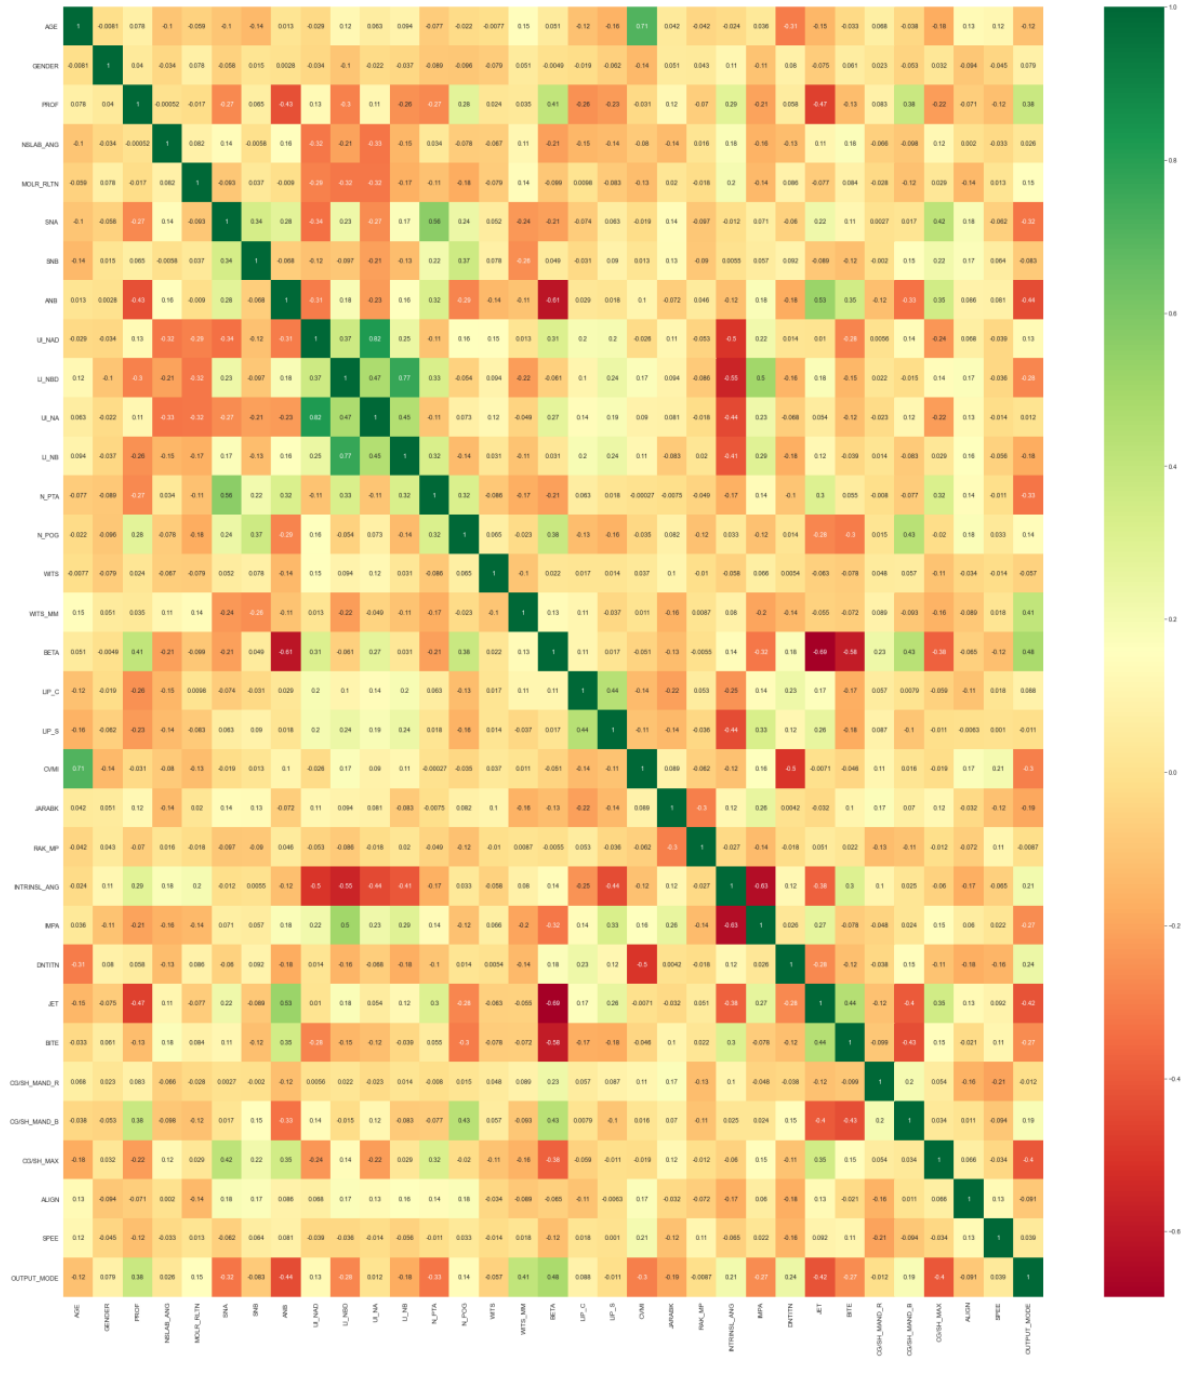
Figure 9. Test data — accuracy. * XGB — eXtreme Gradient Boosting. ** SVM — Support Vector Ma- chine.